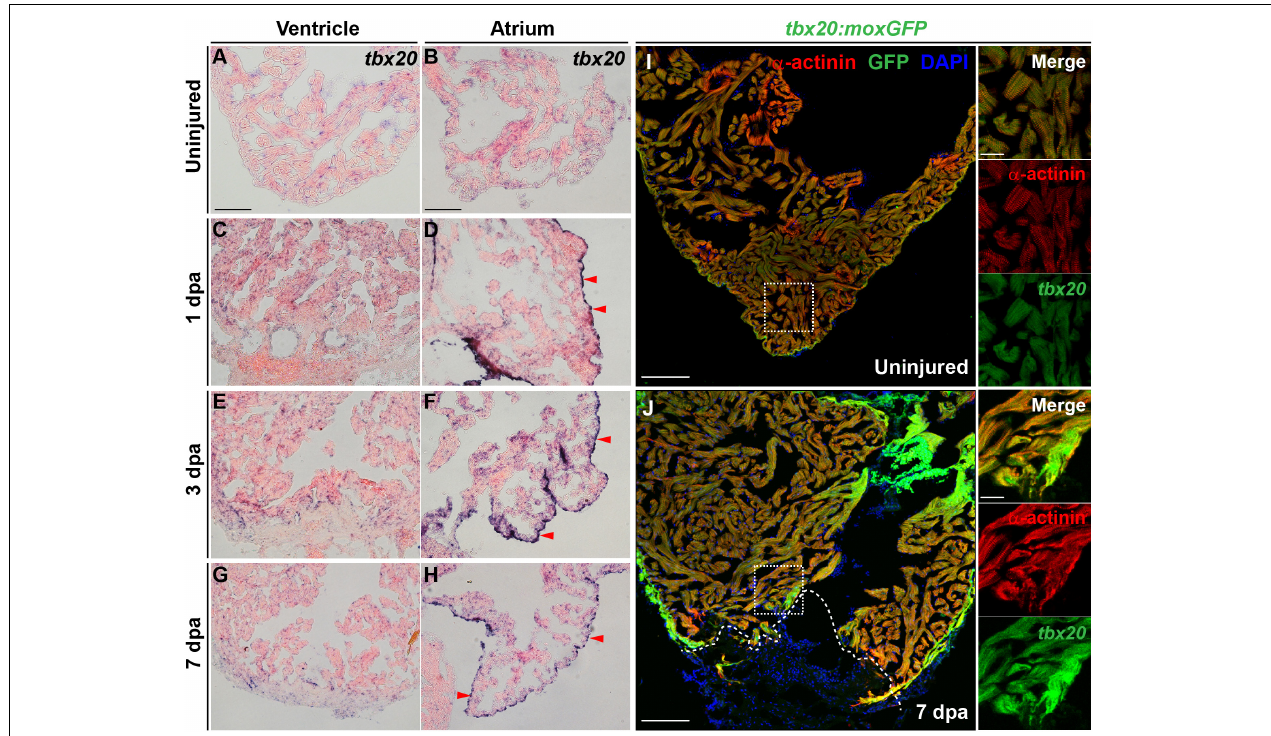
FIGURE 1 | Cardiac injury triggers a localized increase in tbx20 expression. (A–H) Representative images of ISH for tbx20 on the heart sections of uninjured (A,B) and injured ventricles and atriums at different time points as indicated (C–H) . Red arrowheads indicate atrial epicardium. (I,J) Confocal images of uninjured (I) and 7 dpa (J) heart sections from Tg ( tbx20:moxGFP ) zebrafish immunostained for GFP and α -actinin (red). DAPI marks nuclei. Boxed areas are magnified on the right panels. Dashed lines in (J) demarcate amputation planes. Scale bar: 100 µ m (A–J) ; 20 µ m (inset images).